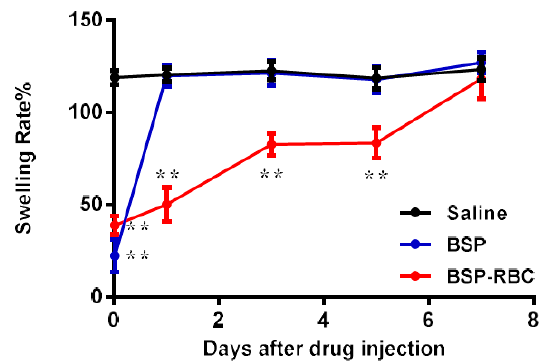
Figure 8. In vivo determination of anti-inflammatory effect. Data are represented as mean ± SD, six samples were used in each group. ** correspond to p ＜ 0.01.